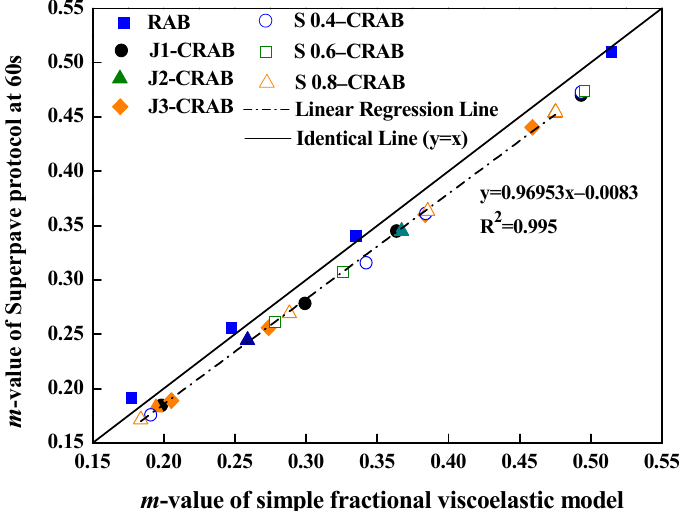
Figure 10. m -Values of simple fractional viscoelastic model versus the Superpave protocol. Figure 10. 𝑚 -values of simple fractional viscoelastic model versus the Superpave protocol.